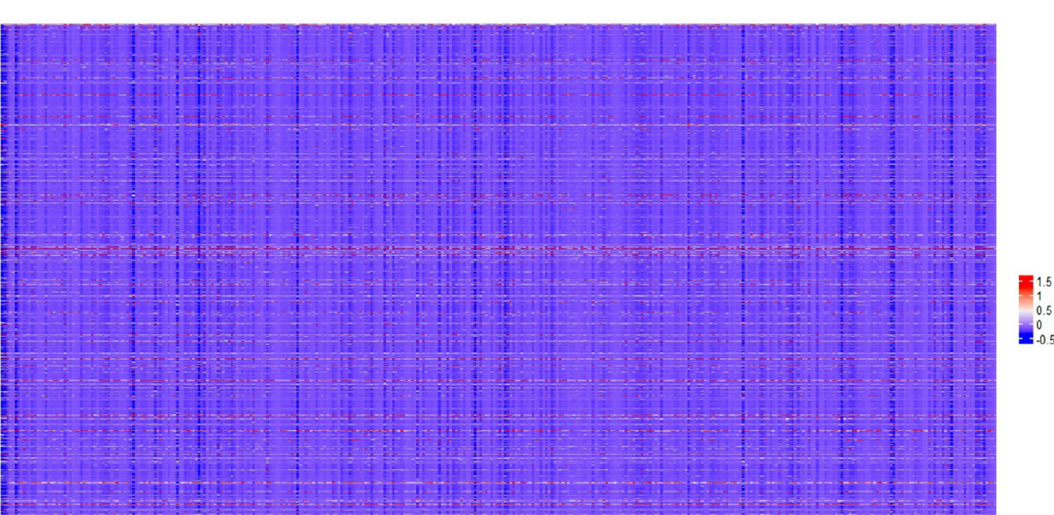
Figure 2. Gene expression profiles of HCC samples. The results obtained by normalizing the RPKM values in 364 HCC samples, each of which contained 4601 genes. A row corresponds to a gene, and a column corresponds to a sample. This figure was drawn with R software 16